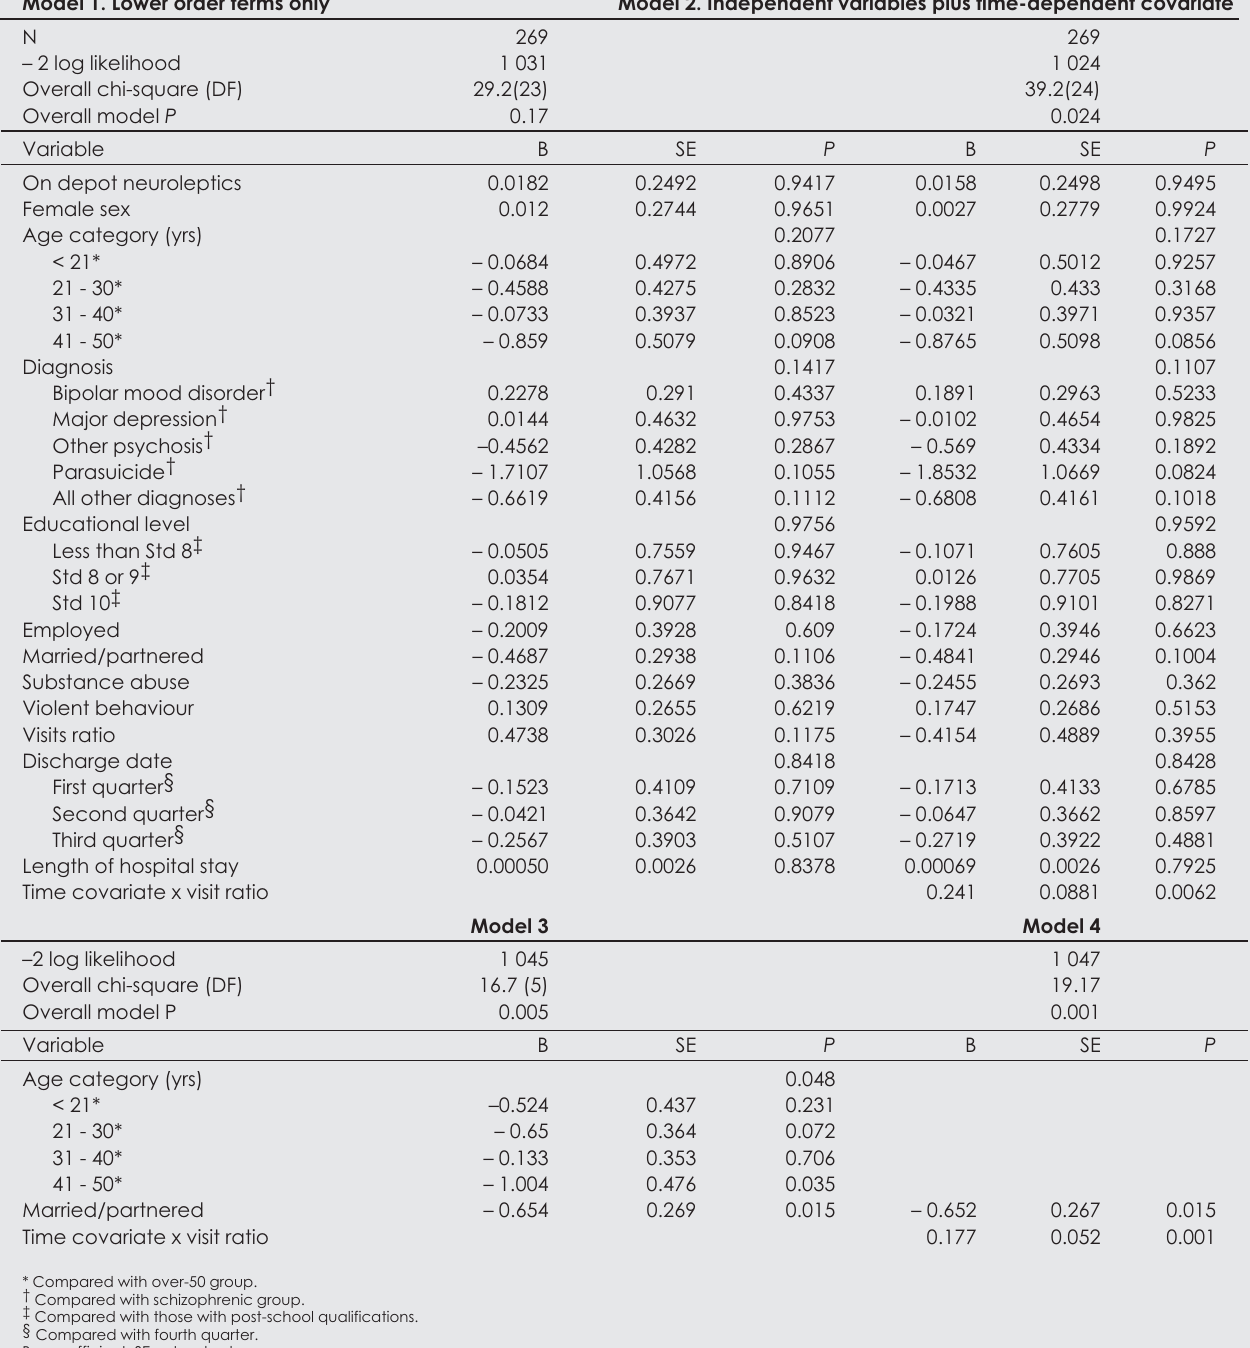
Table III. Model results and stepwise model